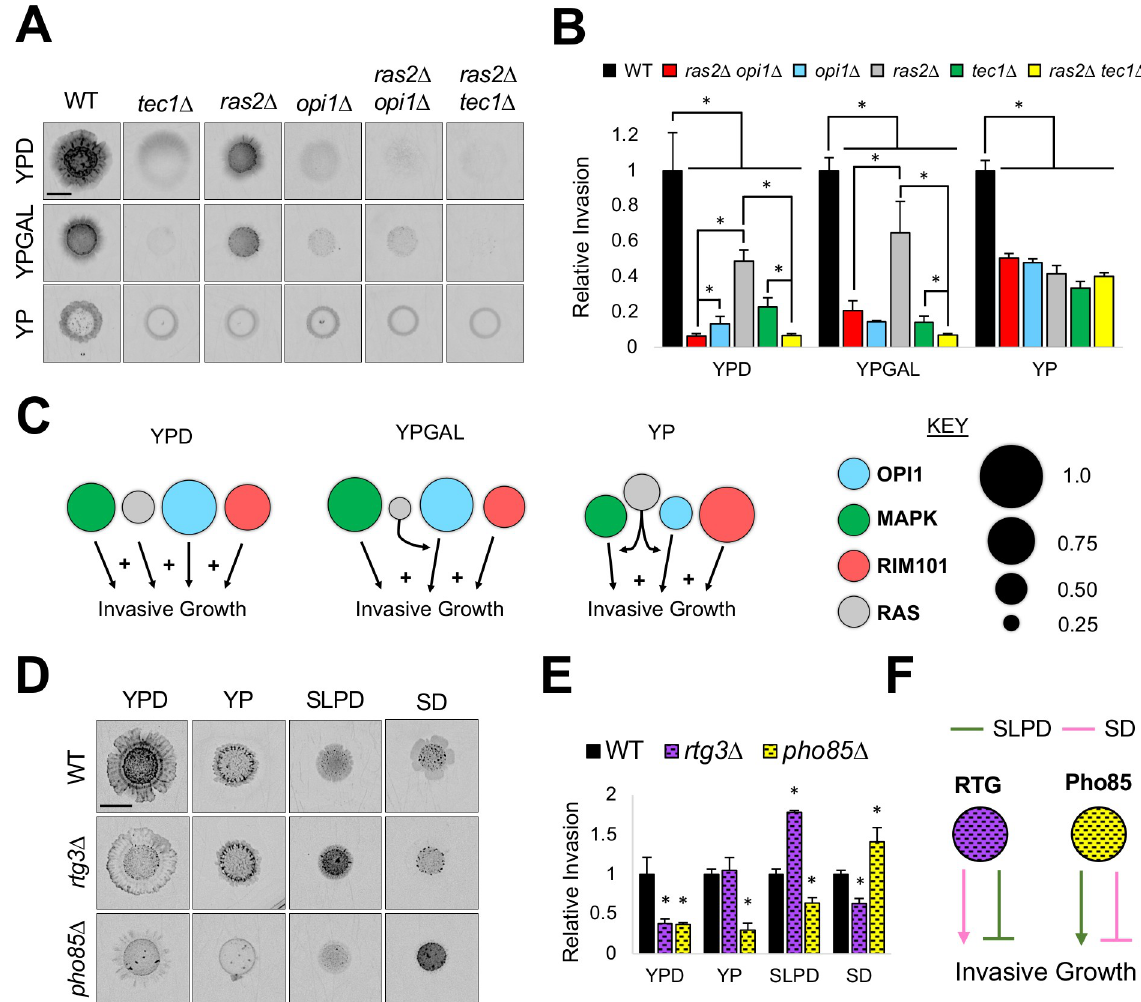
Fig 3. Regulators of invasive growth show conditional redundancy and conditional role reversals. A) PWA. Inverted images of scars after wash, bar, 0.5 cm. Colonies prior to wash in S8 Fig . B) Levels of relative invasion to wild type, with wild-type values set to 1. Asterisk, p- value � 0.05, between the indicated strains by Student’s t-test. C) Model of pathway contributions under different environments. Circle size is proportional to pathway contribution. (+) indicates an additive role. D) PWA, see Panel A for details. Colonies prior to wash in S1 Fig . E) Levels of relative invasion; details in panel B. Asterisk, p-value � 0.05, compared to wild type by Student’s t-test. F) Model of pathway contributions in different